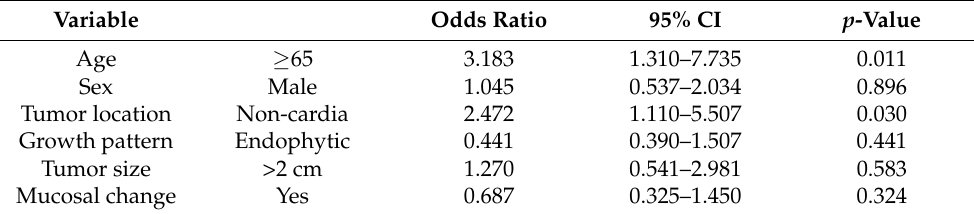
Table 3. Risk factors of GISTs in multivariate analysis.